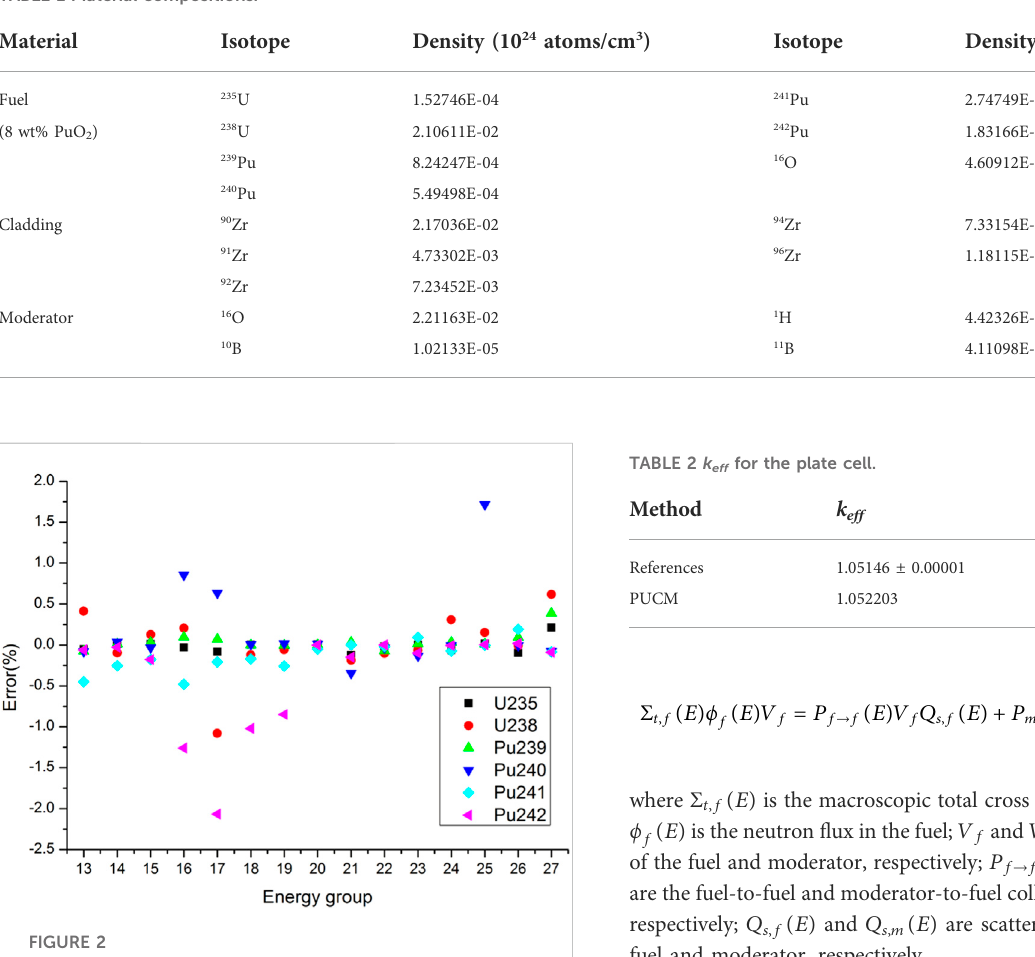
TABLE 1 Material compositions.